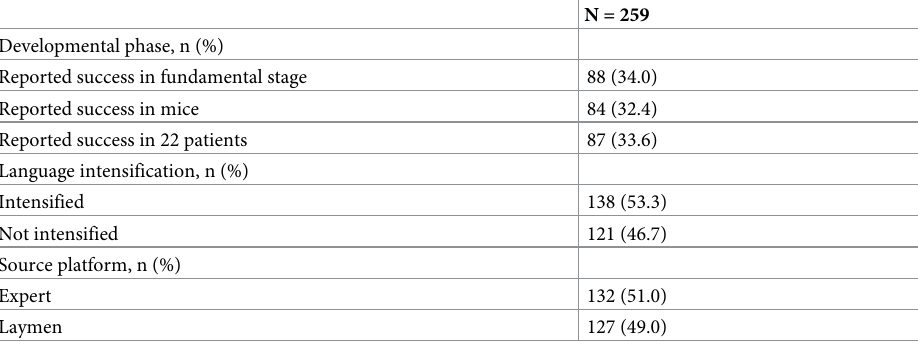
Table 3. Distribution of vignette